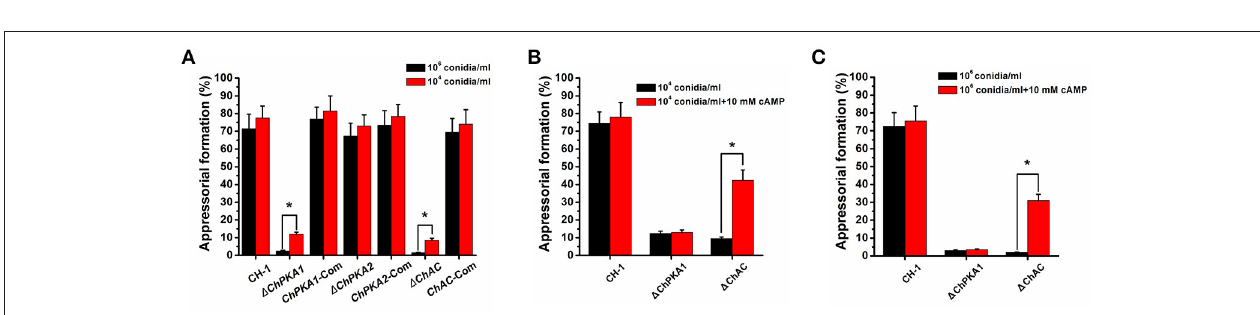
FIGURE 6 | Appressorial formation rate of wild type strain CH-1, ∆ ChPKA1 , ChPKA1 -Com, ∆ ChPKA2, and ∆ ChAC on hydrophobic coverslips. (A) Appressorial formation rate of indicated strains at different conidial density (10 6 and 10 4 conidia/ml, respectively) on hydrophobic coverslips at 25 ◦ C for 24 h. (B) Appressorial formation rate of CH-1, ∆ ChPKA1, and ∆ ChAC at 10 4 conidia/ml with or without exogenous 10mM cAMP on hydrophobic coverslips at 25 ◦ C for 24 h. (C) Appressorial formation rate of CH-1, ∆ ChPKA1, and ∆ ChAC at 10 6 conidia/ml with or without exogenous 10mM cAMP on hydrophobic coverslips at 25 ◦ C for 24 h. Asterisks in the graph indicate statistical differences, P ≤